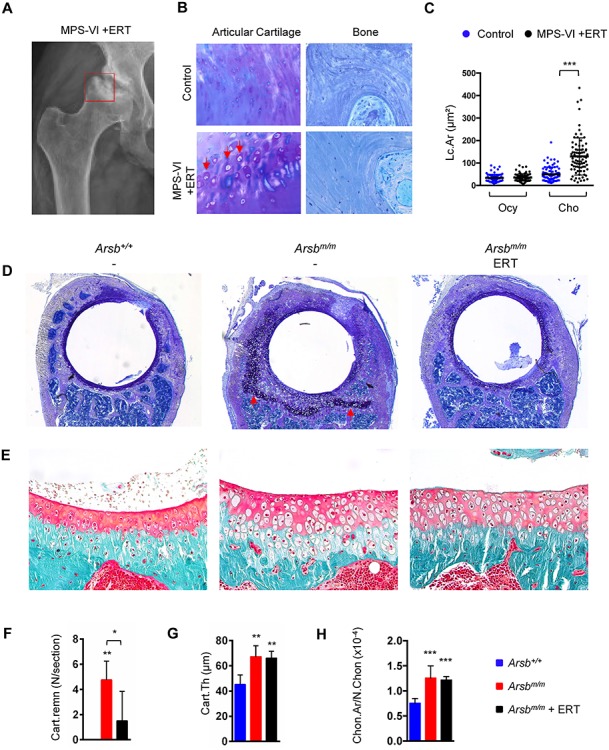
Articular chondrocyte pathologies are not prevented by ERT in an MPS-VI patient and in Arsb-deficient mice. (A) Hip radiograph of a 30-year-old female patient with MPS-VI, who received ERT for the last 4 years. The pathologically affected region (femoral head and acetabulum) is highlighted by the red square. (B) Representative images of articular cartilage (left) and bone (right) in bone biopsies of a control individual and the ERT-treated MPS-VI patient. Enlargement of articular chondrocytes is indicated by the arrows. (C) Quantification of the cellular size increase (Lc.Ar. lacunar area) in osteocytes (Ocy) and articular chondrocytes (Cho) in the different biopsies. (D) Representative images showing the acetabulum from 24-week-old wild-type (Arsb+/+), untreated (Arsbm/m) or treated (Arsbm/m ERT) Arsb-deficient mice after toluidine blue staining. The dark staining indicates the presence of cartilage remnants in untreated Arsb-deficient mice (arrows). (E) Representative images showing the articular regions from the same samples after Goldner staining. Note the enlarged cell sizes and increased cartilage thickness in untreated and treated Arsb-deficient mice. (F) Quantification of cartilage remnants (Cart.Remn.) in the acetabulum from wild-type (blue bars), untreated (red bars) or treated (black bars) Arsb-deficient mice at 24 weeks of age (n ≥ 5 mice per group). (G) Quantification of articular cartilage thickness (Cart.Th.) in the same samples (n ≥ 5 mice per group). (H) Quantification of articular chondrocyte size (Chon.Ar/N.Chon, chondrocyte area per number of chondrocytes) in the same samples (n ≥ 5 mice per group). Data are expressed as mean ± SD. *P < 0.05, **P < 0.005, ***P < 0.0005 (one-way ANOVA).